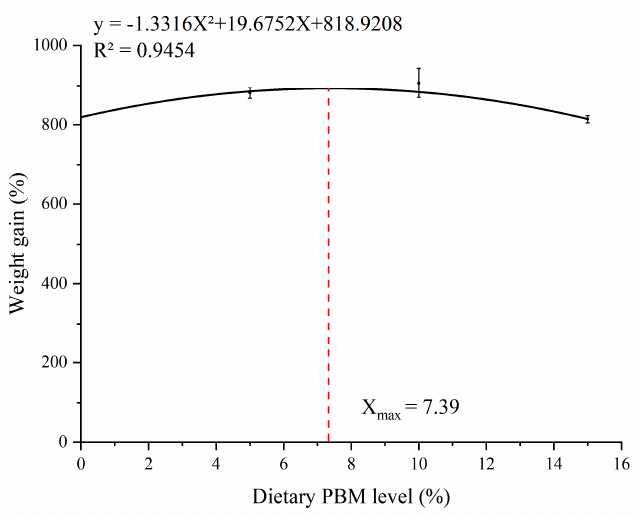
Figure 1. The relationship between WG and dietary PBM replacement level in Chinese soft-shelled turtle.